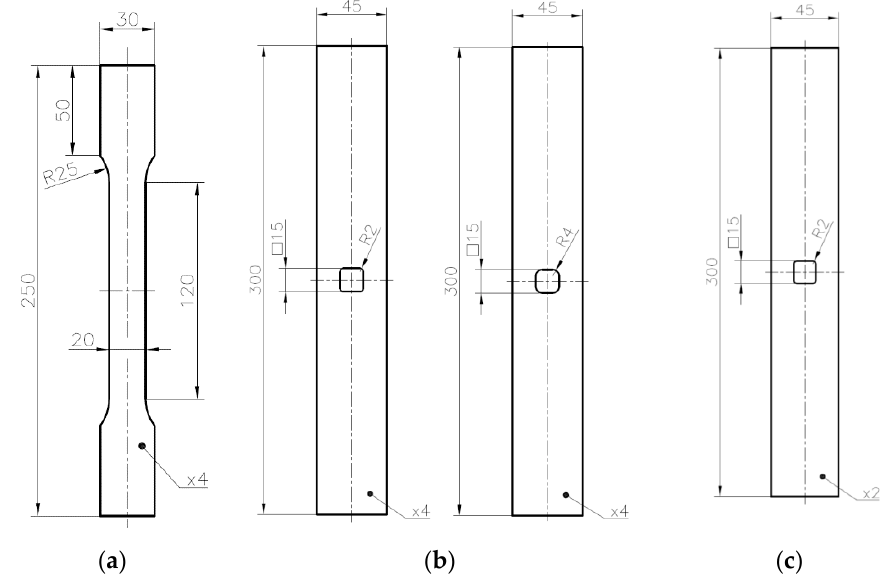
Figure 2. Dimension of investigated samples: ( a ) S355MC, Samples 7–8; ( b ) S355MC, Samples 9–10; and ( c ) 41Cr4, Samples 11–15.